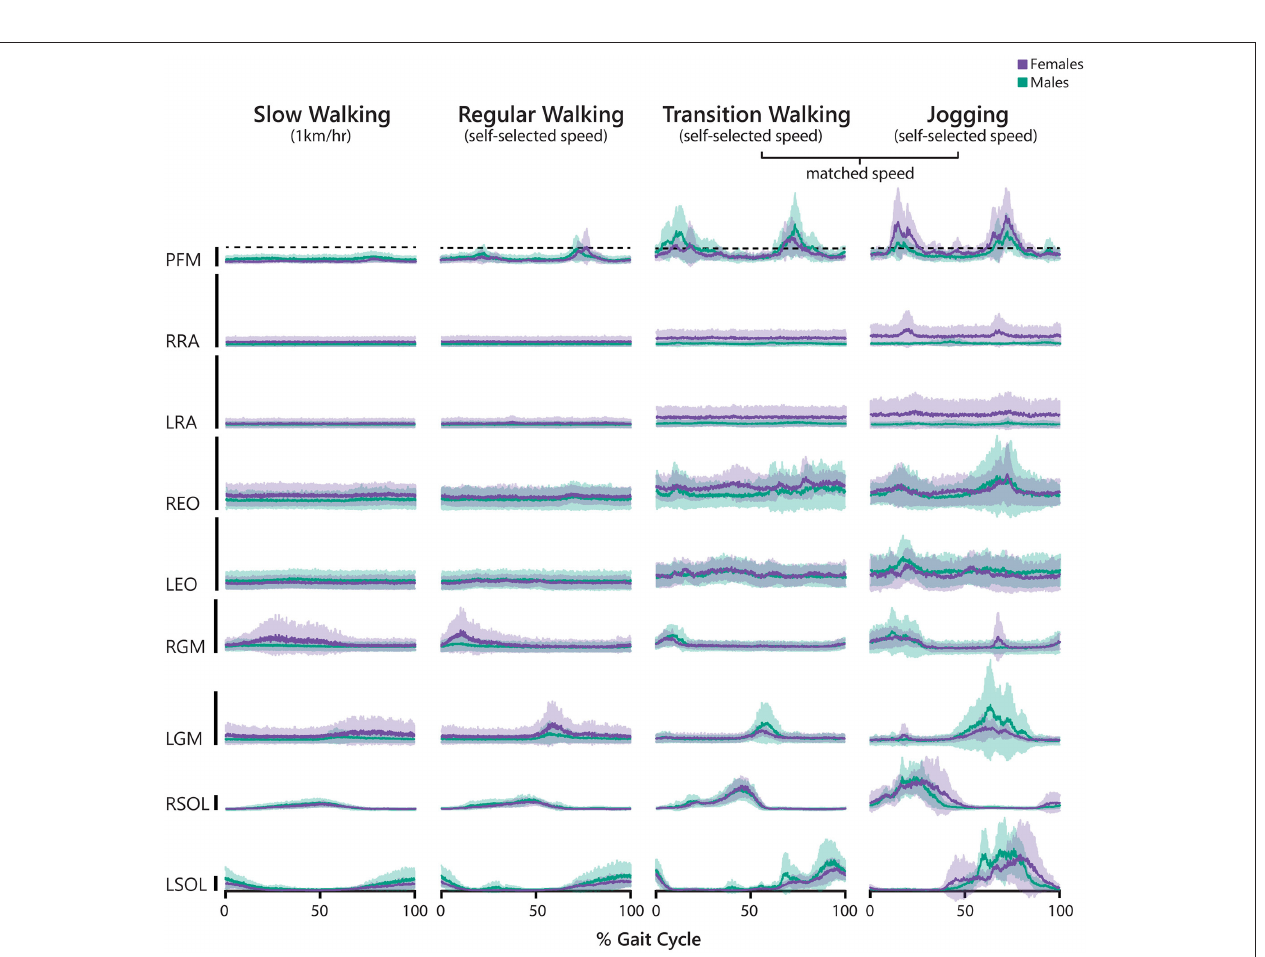
FIGURE 2 | Averaged electromyography (EMG) signals recorded during slow walking, regular walking, transition walking, and jogging normalized to gait cycle (0% indicates right heel strike). Prior to averaging across participants, we normalized each individual trace to the participant’s attempted maximum voluntary contraction (aMVC) for that muscle. The black vertical bars represent 100%aMVC for that muscle. Male participants are depicted using green tones, and female participants are depicted using purple tones. Solid lines represent the average EMG activity and the shaded bands represent the 95% confidence interval. PFM, pelvic floor muscles; R/LRA, right/left rectus abdominis; R/LEO, right/left external oblique; R/LGM, right/left gluteus maximus; R/LSOL, right/left soleus.